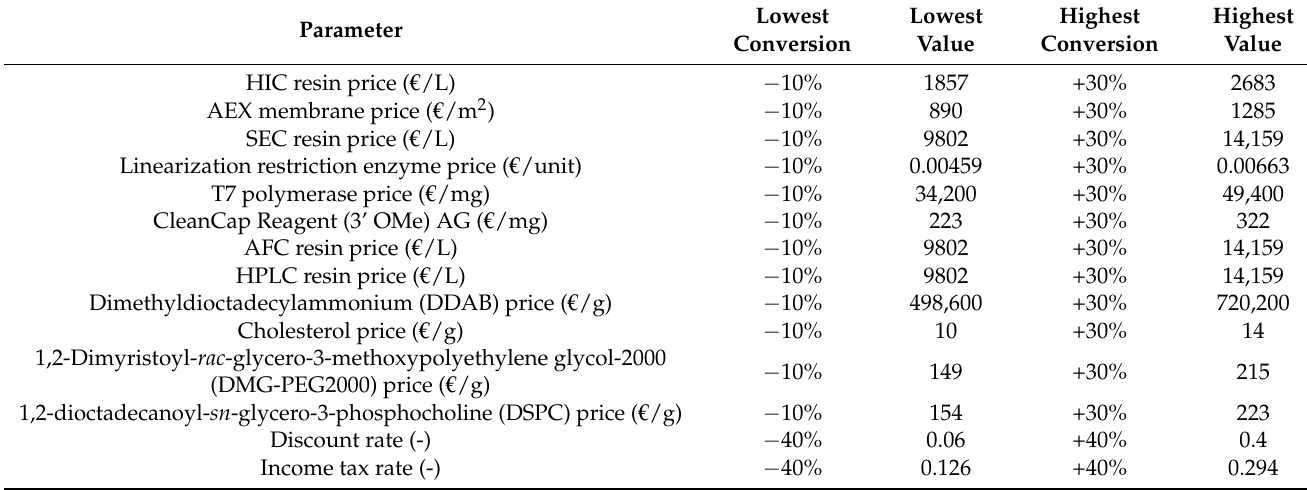
Table 3. Uncertainty analysis